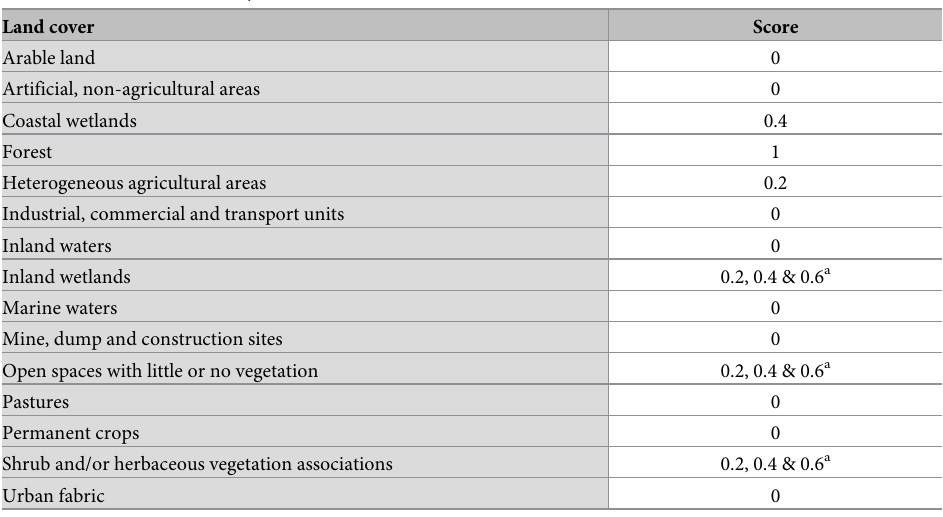
Table 2. Land cover suitability